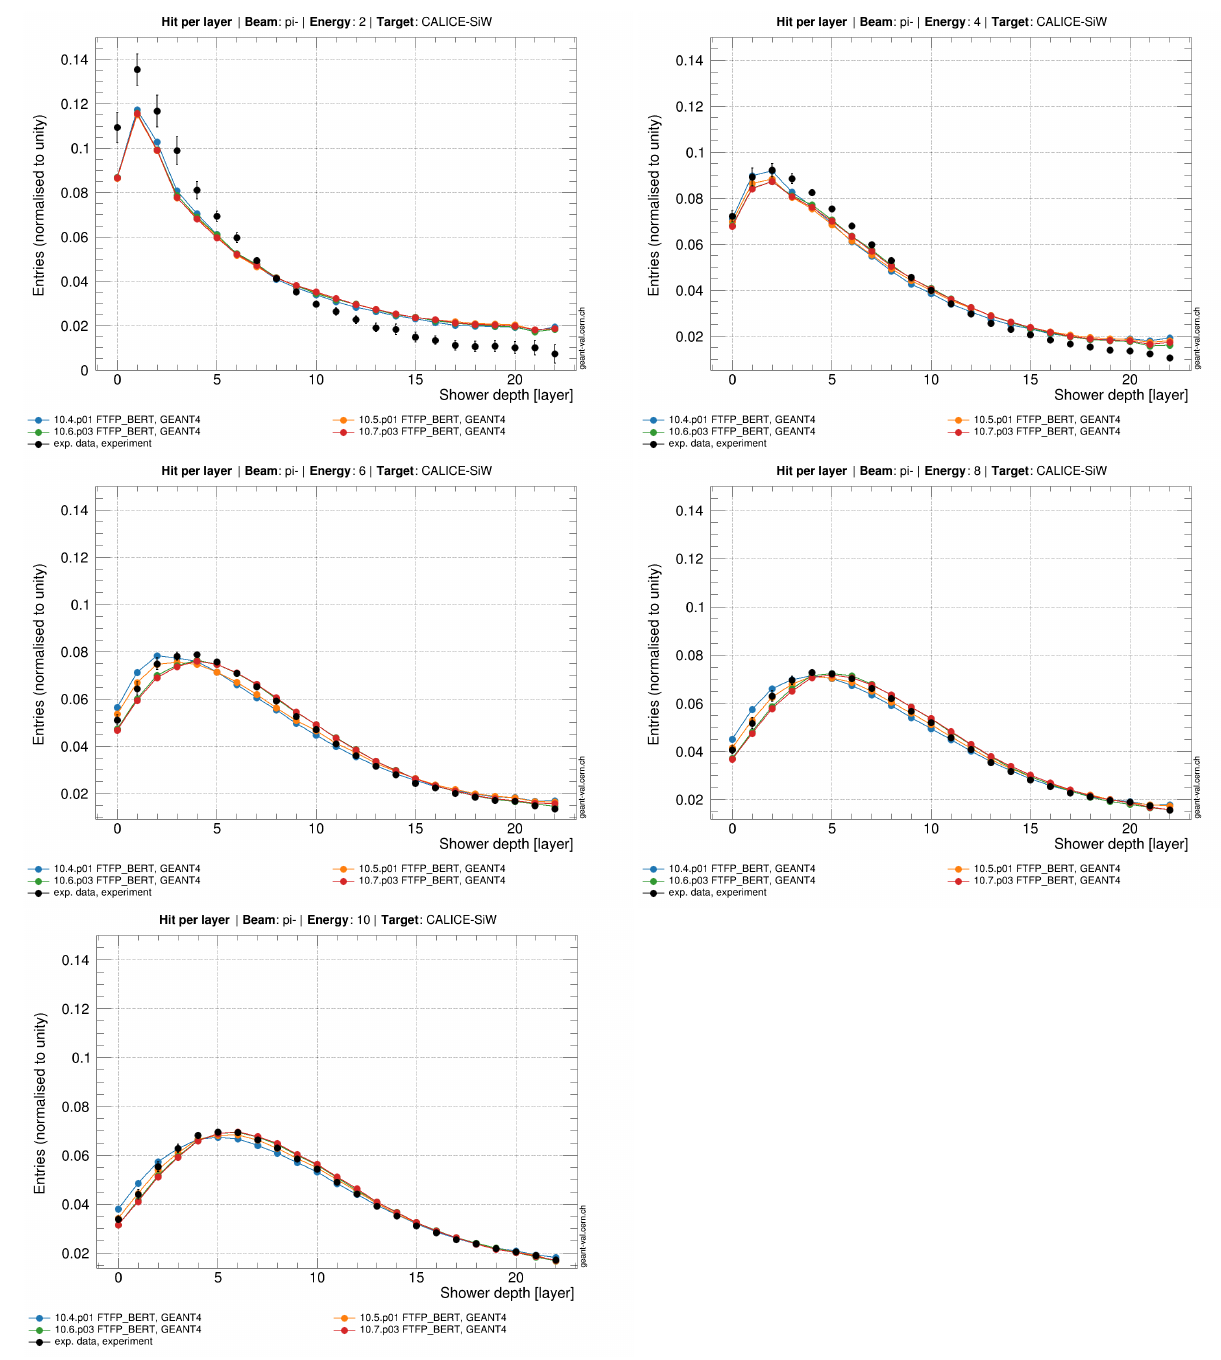
Figure 8. Experimental data are compared to the FTFP_BERT prediction for Geant4 releases from 2017 to 2020. Simulated results are stable over the years and indicate a better capability to reproduce longitudinal hit distributions in the 6–10 GeV energy scale with respect to the 2–4 GeV one. It corresponds to a higher precision in the hit distribution description for the Fritiof string model as compared to the Bertini intra-nuclear cascade one. Similar results are obtained with the FTFP_INCLXX PL and are available on the geant-val website.